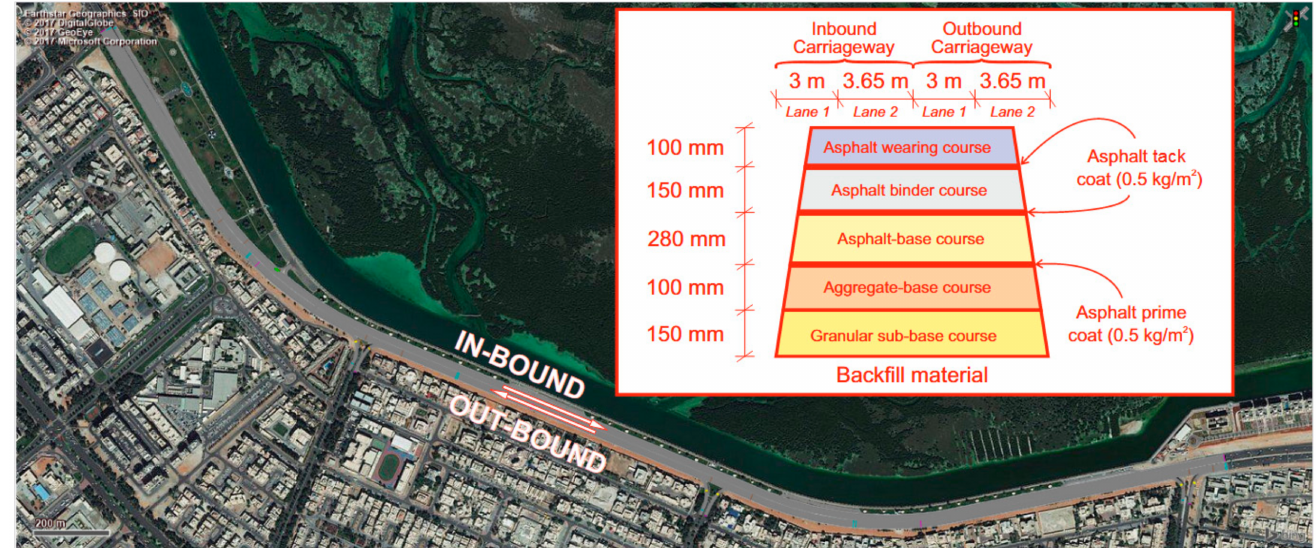
Figure 1. Case study of the asphalt pavement